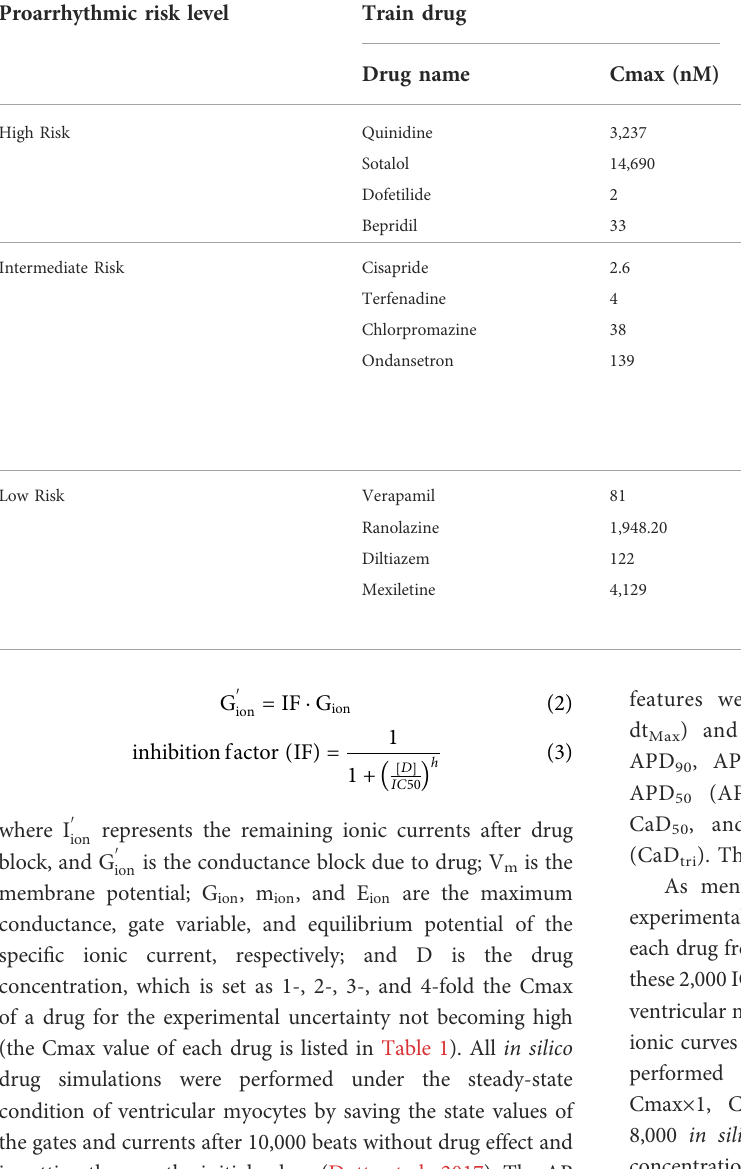
TABLE 1 List of the 28 drugs and their corresponding Cmax values. Proarrhythmic risk